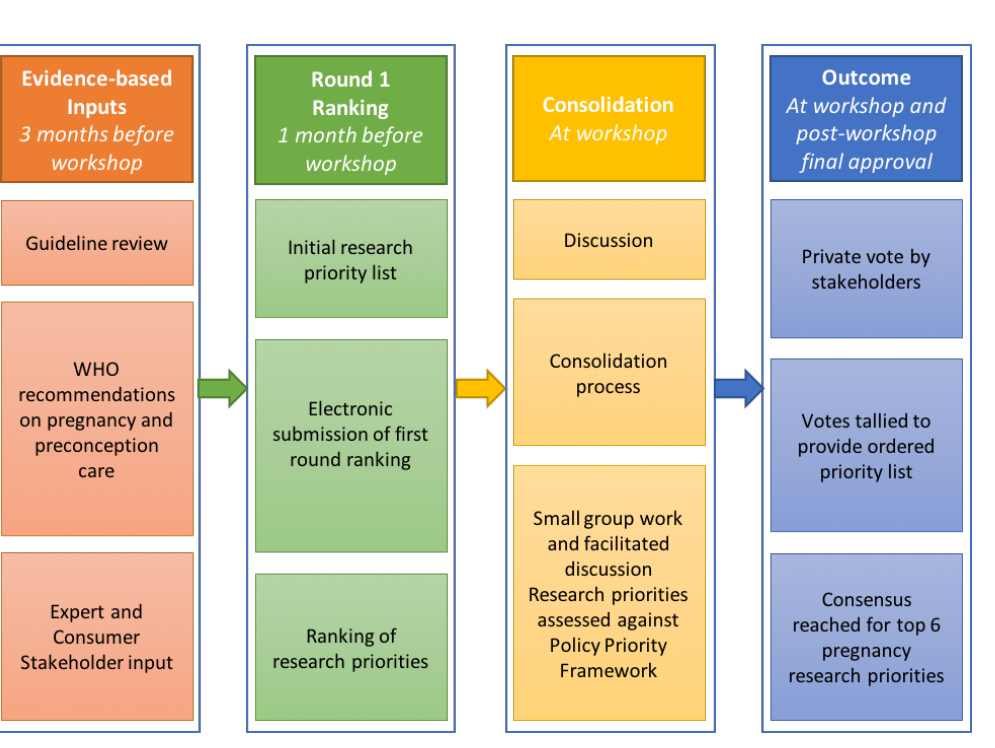
Figure 1. Process of establishing consensus on pregnancy research priorities.